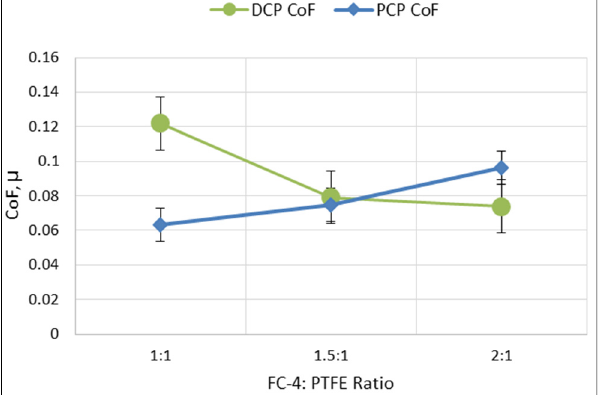
Figure 6. Mean coefficient of friction (CoF) for the DCP and PCP samples by FC ‐ 4:PTFE ratio.